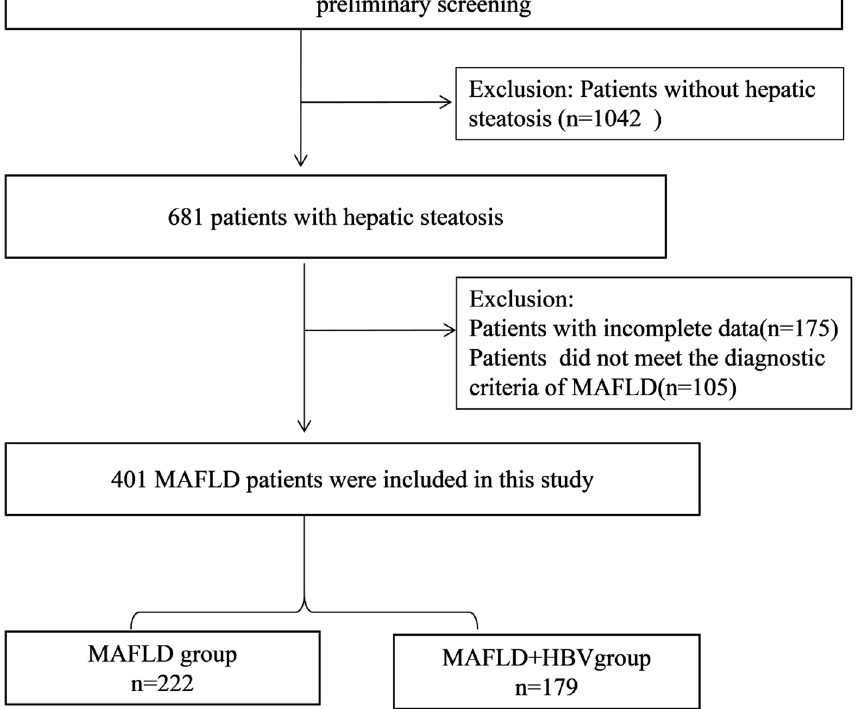
Figure 1. Design of the cross-sectional study. MAFLD, metabolic dysfunction-associated fatty liver